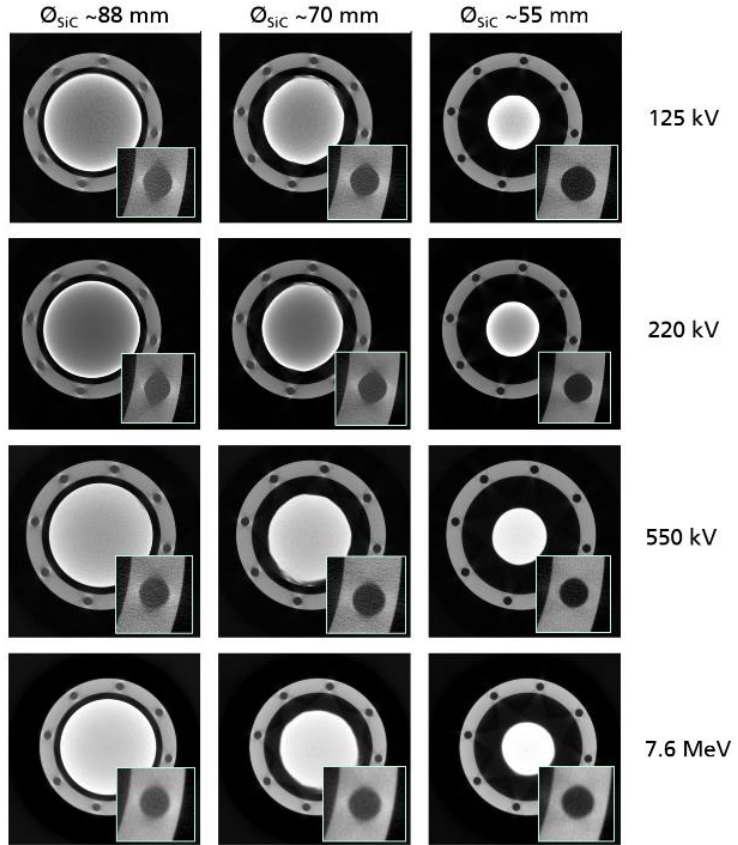
Figure 7. Comparison of the di ff erent CT scan results obtained using di ff erent X-ray energies. Each row represents a cross-section with a varying crystal diameter leading to di ff erent quality of reconstruction. The digitally zoomed hole indicates the contrast capability of the di ff erent settings.